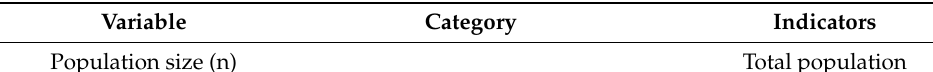
Table 2. Variables and related